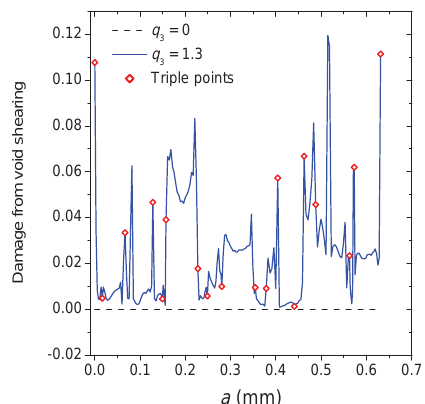
Figure 16. The damage caused by void shearing along the crack propagation path for two different values of q 3